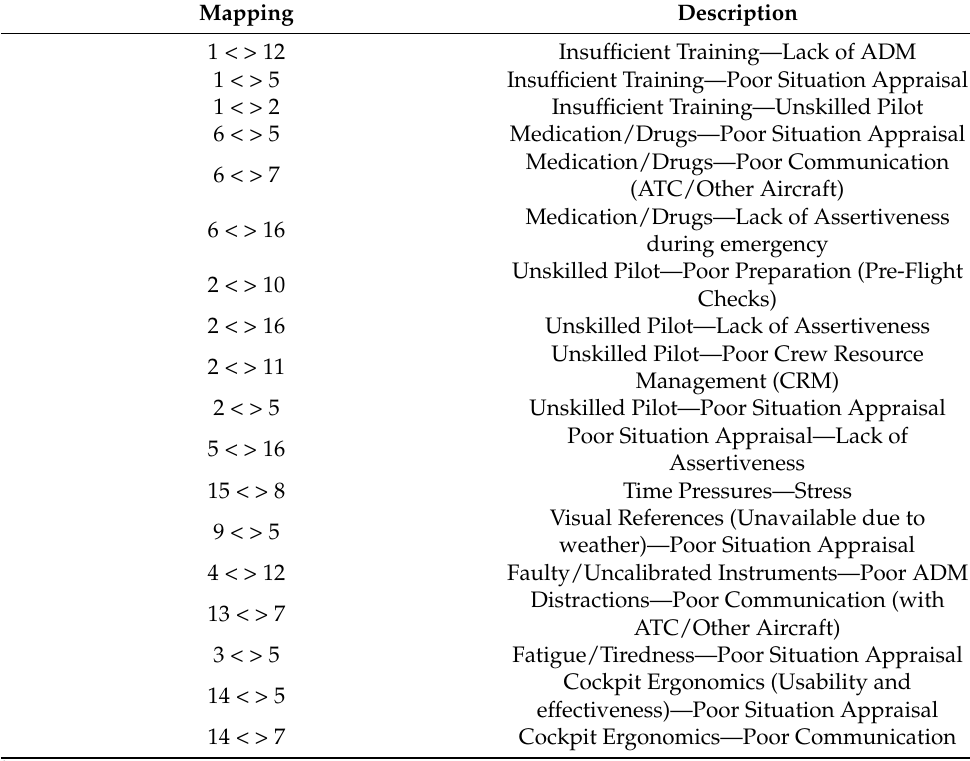
Table 6. Mapping of the concepts in the FCM model 1